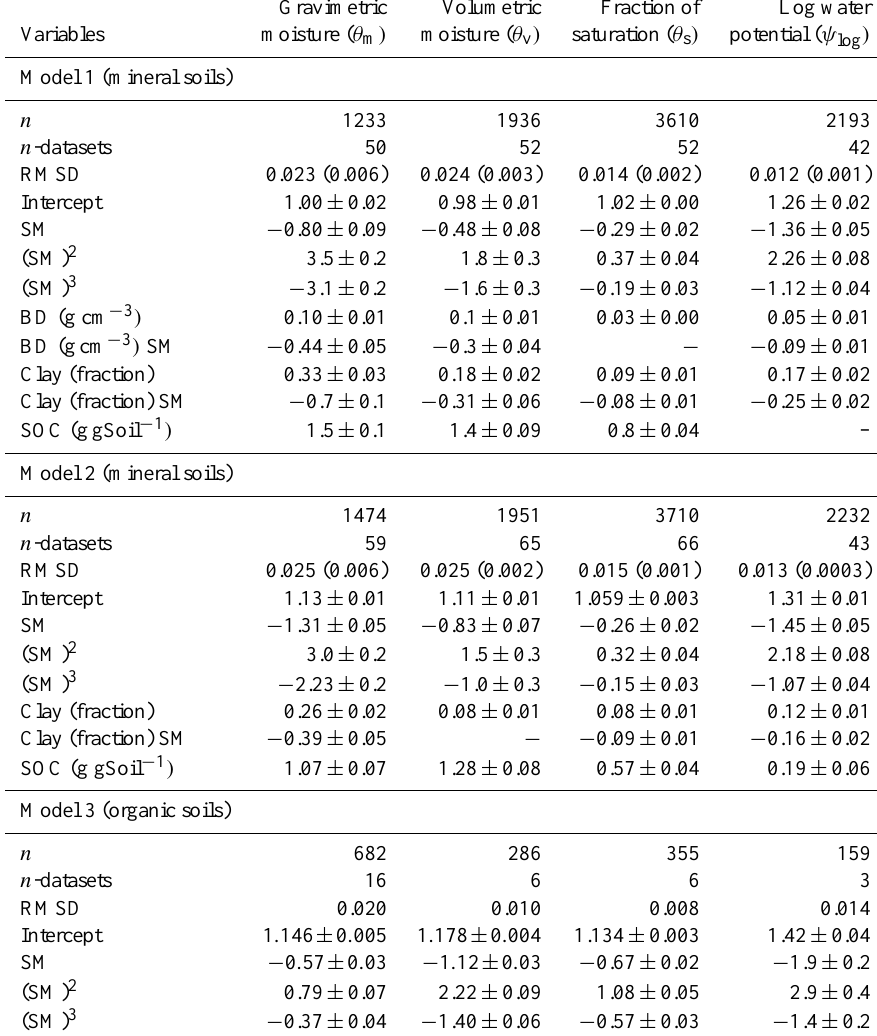
Table 3. Variables and coefficients for linear models predicting the proportional response of soil respiration (PR SR ) at 0.01 moisture intervals. SM=soil moisture, BD=bulk density, SOC=soil organic carbon. Coefficient values and standard errors are given under the corresponding moisture measure. All terms are significant at p < 0 . 001. In addition, values are given for the number of data points ( n ) and datasets used, and the model root mean square deviation (RMSD) with the improvement relative to a moisture-only fit in